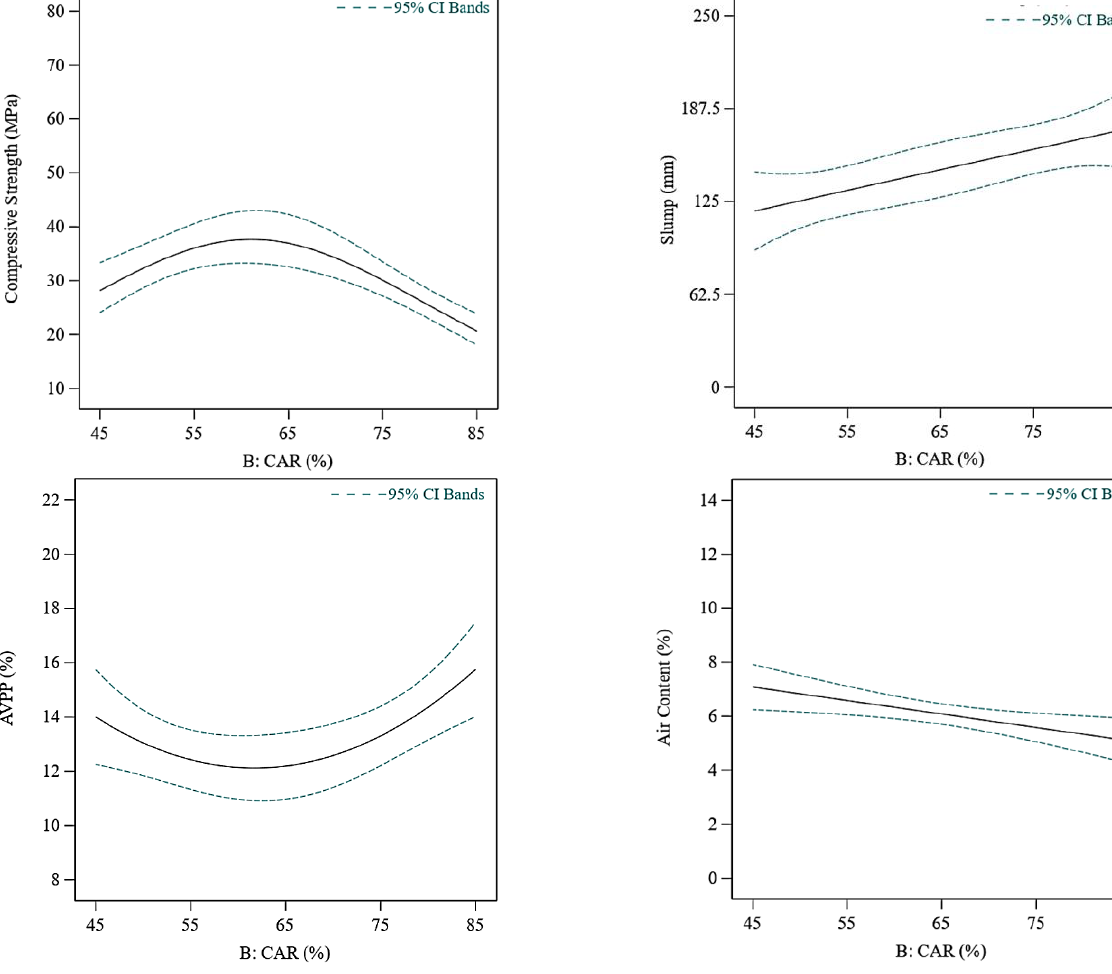
Figure 6. Effect of CAR on compressive strength, slump, AVPP, and air content.